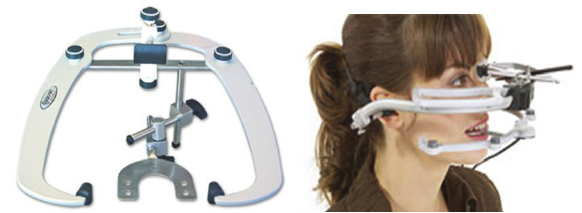
Figure 6: Inflammation measurement by facebow.